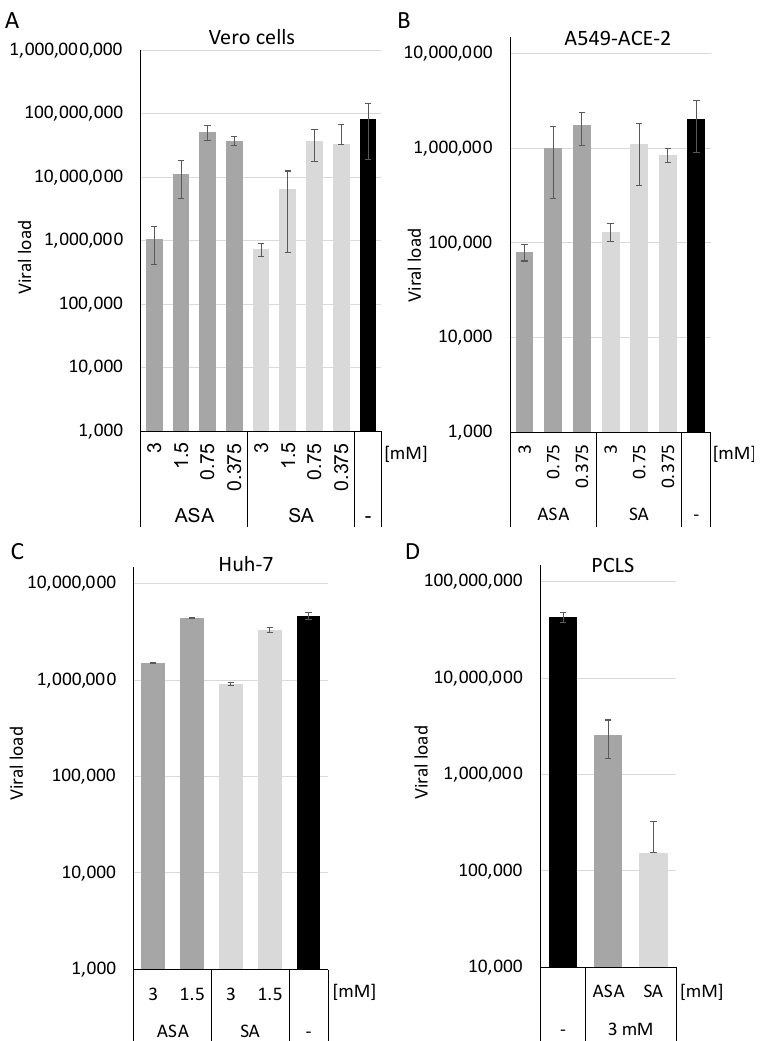
Figure 1. SA and ASA inhibit viral replication in Vero, A549-ACE2, Huh-7 cells and human precision-cut lung slices. Vero ( A ), A549-ACE2 ( B ) and Huh-7 ( C ) cells, as well as PCLS ( D ), were treated with the compounds and infected with SARS-CoV-2. Viral loads were determined 3 days after infection. Bars represent the mean, and error bars the standard deviation.